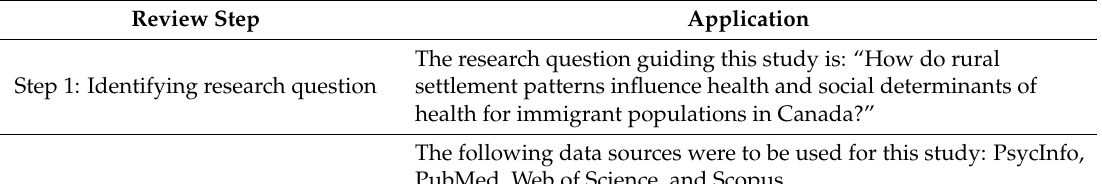
Table 1. Applying the stages of scoping review protocol